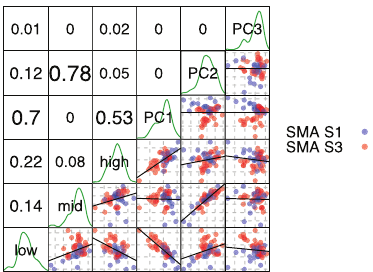
Figure 8. Correlations of low-, mid- and high-frequency CPX levels with the 3D texture principal components. The lower triangle depicts the individual scatter plots, the upper triangle the coef fi cient of determination of the respective linear regres- sion. The parameter names in the diagonal denote the variables on the axes of the matrix elements, e.g. the lowest row depicts the individual scatter plots of mid, high, and PC1 to PC3 variables on the abscissa vs. the low-frequency component on the ordinate. In addition, the diagonal elements also show the variables ’ kernel density estimate.